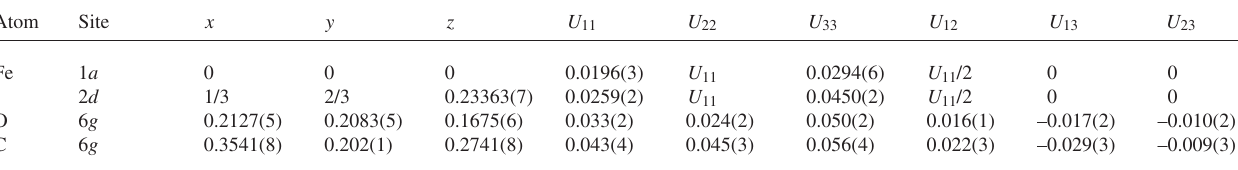
Table 3. Atomic coordinates and displacement parameters (in Å 2 ) .